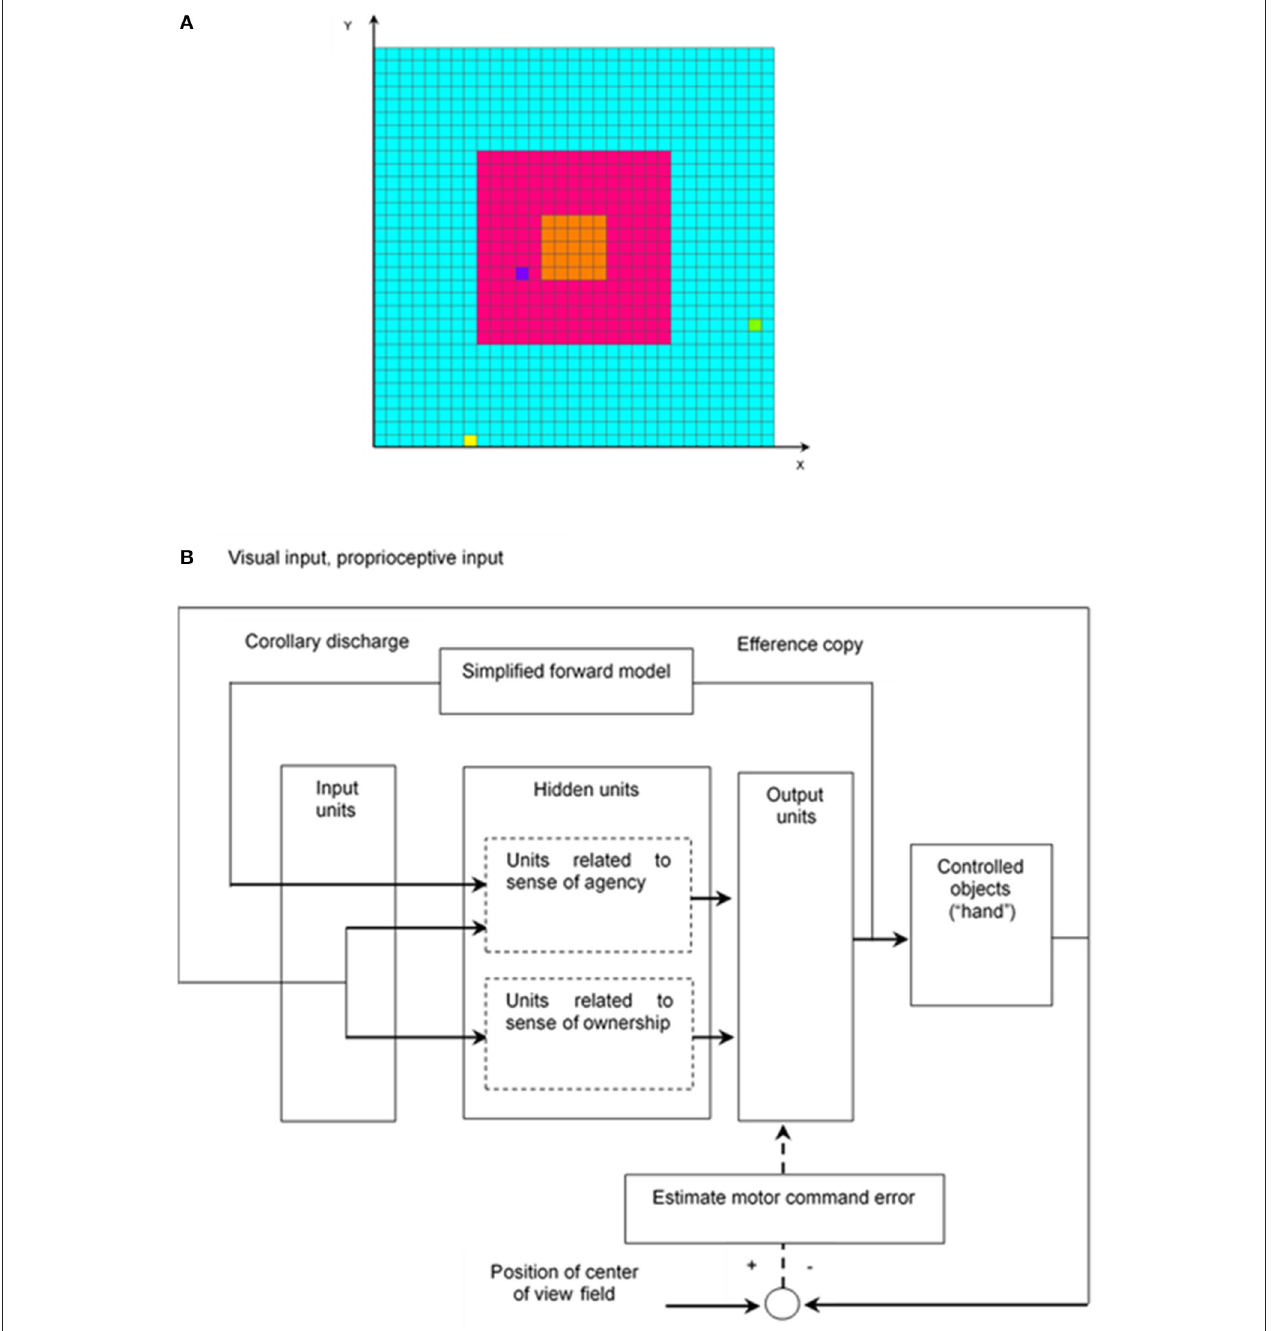
FIGURE 1 | Simulation model for learning hand regard. (A) Infant’s field of view and reachable area of infant’s hands and the other object. The left hand and right hand of the infant and the other object, which are represented by the yellow, yellow-green, and blue squares, respectively, can move to the blue, red, and orange areas. The width corresponds to the length of the infant’s outstretched arms. The red and orange areas are the infant’s field of view, and the orange one is the center of the field of view. (B) Block diagram of learning hand regard.